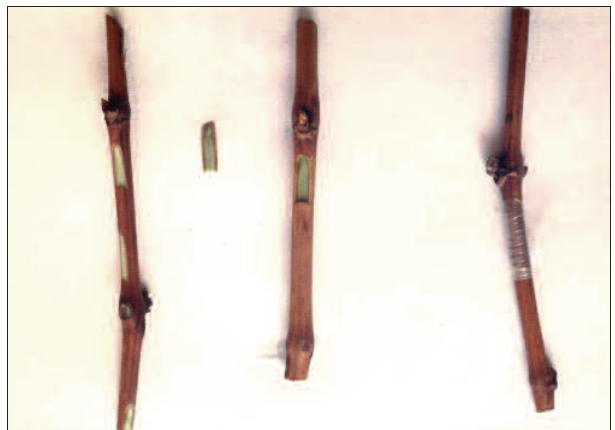
Figure 1. Woody indexing by chip-transmission